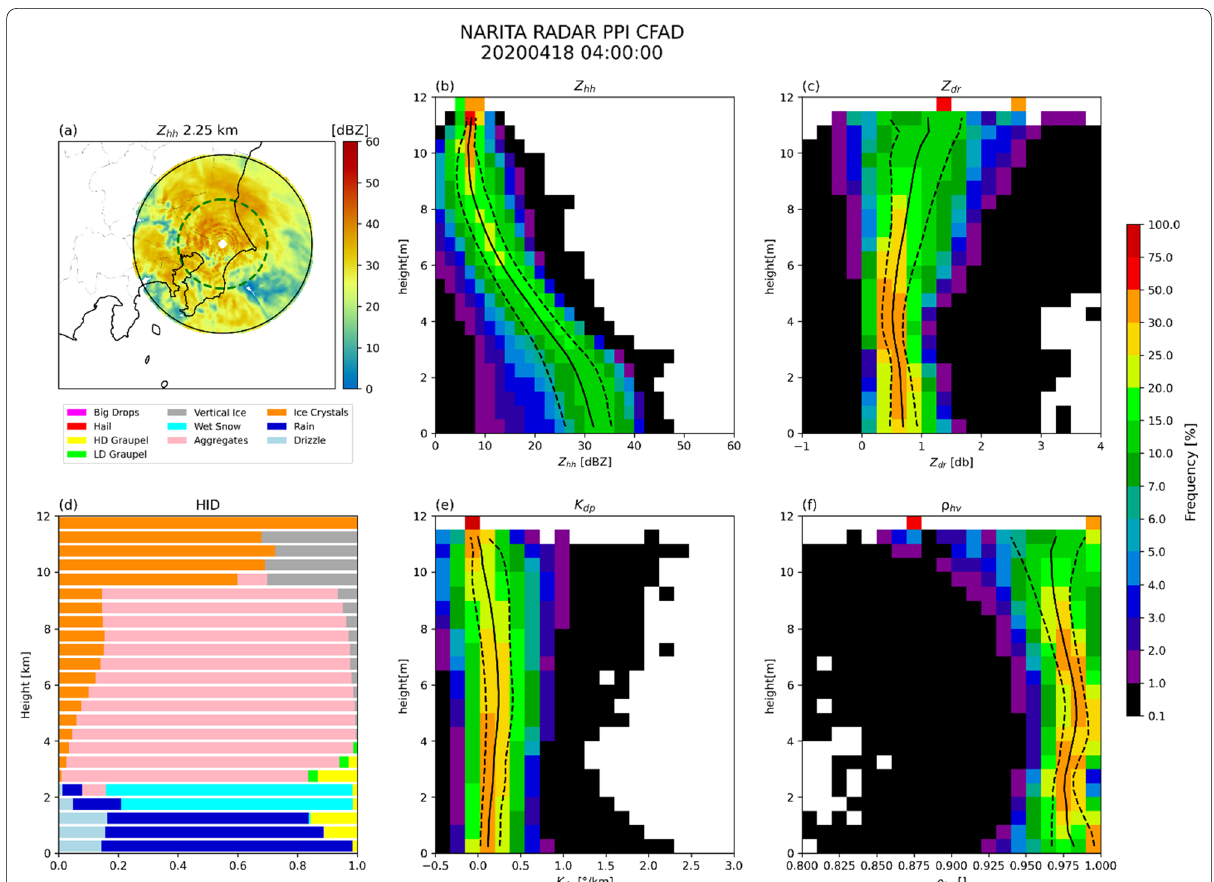
Fig. 14 The statistical vertical distributions of the polarimetric parameters for the observation by the Narita radar at 04:00 UTC, April 18, 2020. a the horizontal distribution of radar reflectivity Z hh at an altitude of 2.25 km; the same as Fig. 4a. CFADs of b radar reflectivity Z hh [dBZ], c differential reflectivity Z dr [dB], d HID, e specific differential phase K dp [° km − 1 ], and f copular correlation coefficient ρ hv . The solid curve is the median, and the dashed curves are the 25 and 75 percentiles of the observed PDF at each